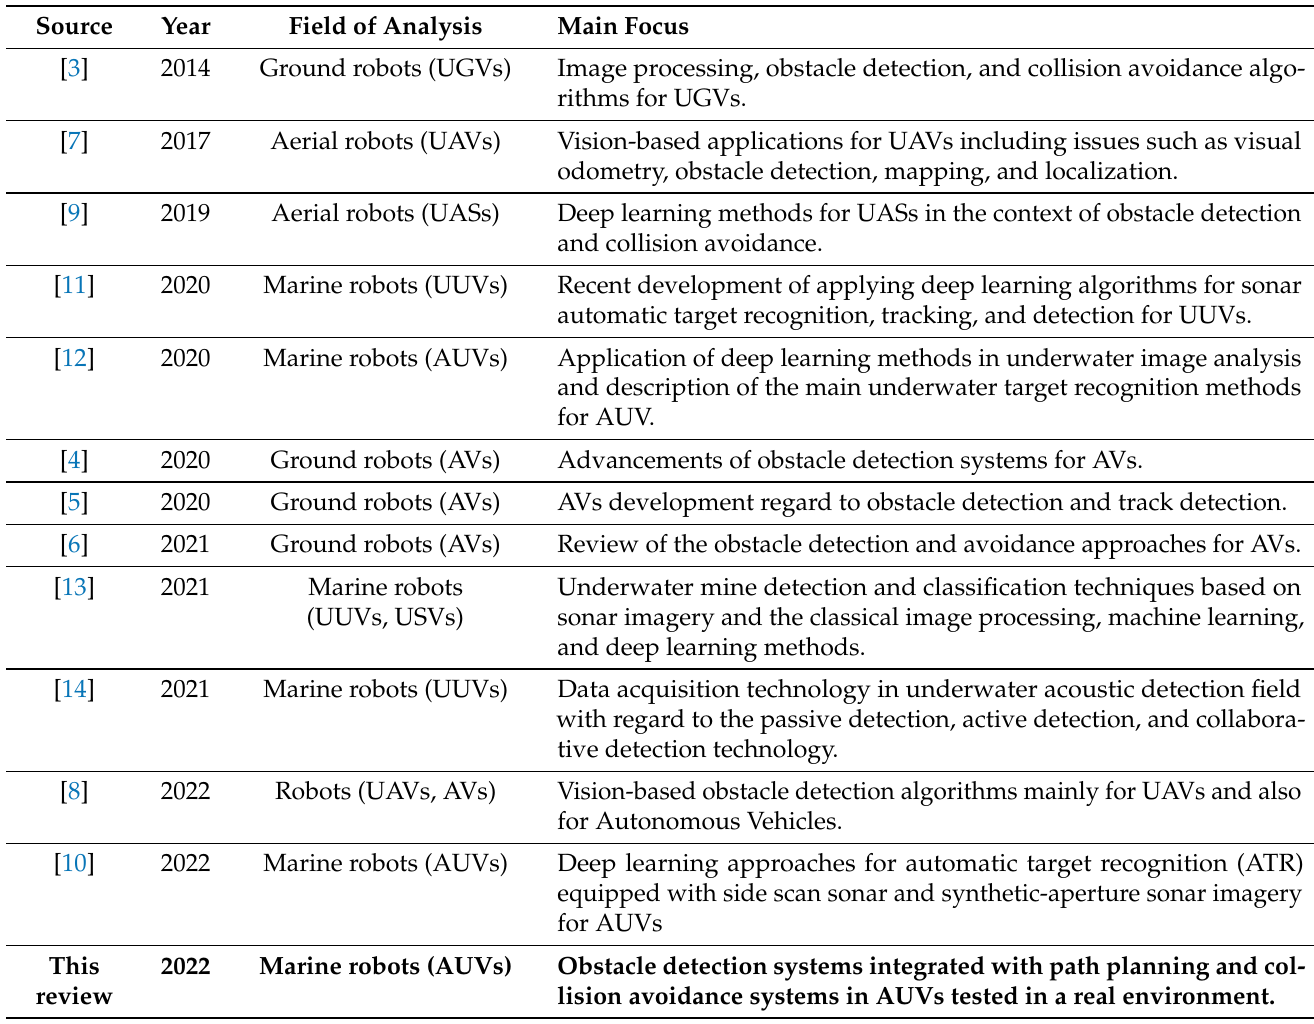
Table 1. The main surveys connected with obstacle detection methods for